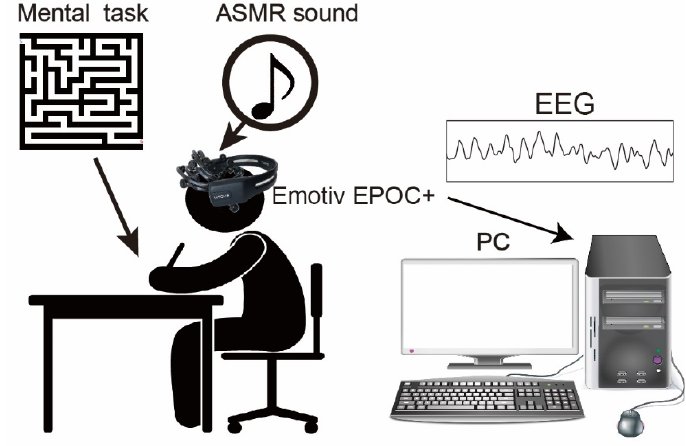
Figure 1. The experimental setup and mental task. Subjects sat on the chair and performed the mental task. The 40 × 40 size mazes printed on A4 paper were employed as our mental task, and the subject continuously solved them for 3 min. An Emotiv EPOC+ (14 channels) was utilized to measure human EEG. In the experiment, the ASMR sound was given by a headphone.